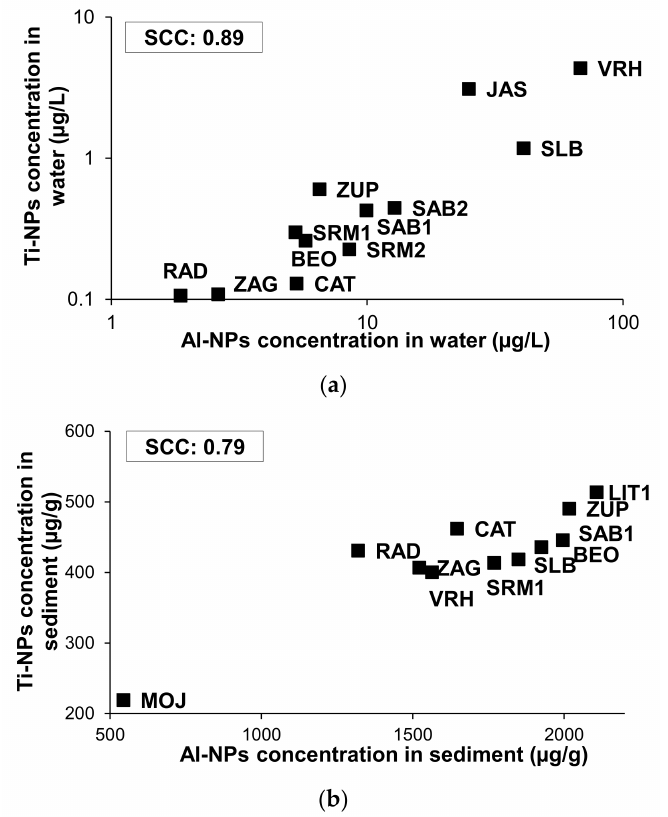
Figure 4. Correlation between mass concentrations of Ti- and Al-containing NPs determined by spICP-MS in ( a ) river water and ( b ) sediment samples (when excluding data from JAS). Log-log plot in graph ( a ). Spearman correlation coefficients (SCCs) are presented in graph ( a , b ). However, it must be emphasized that the applied extraction procedure was